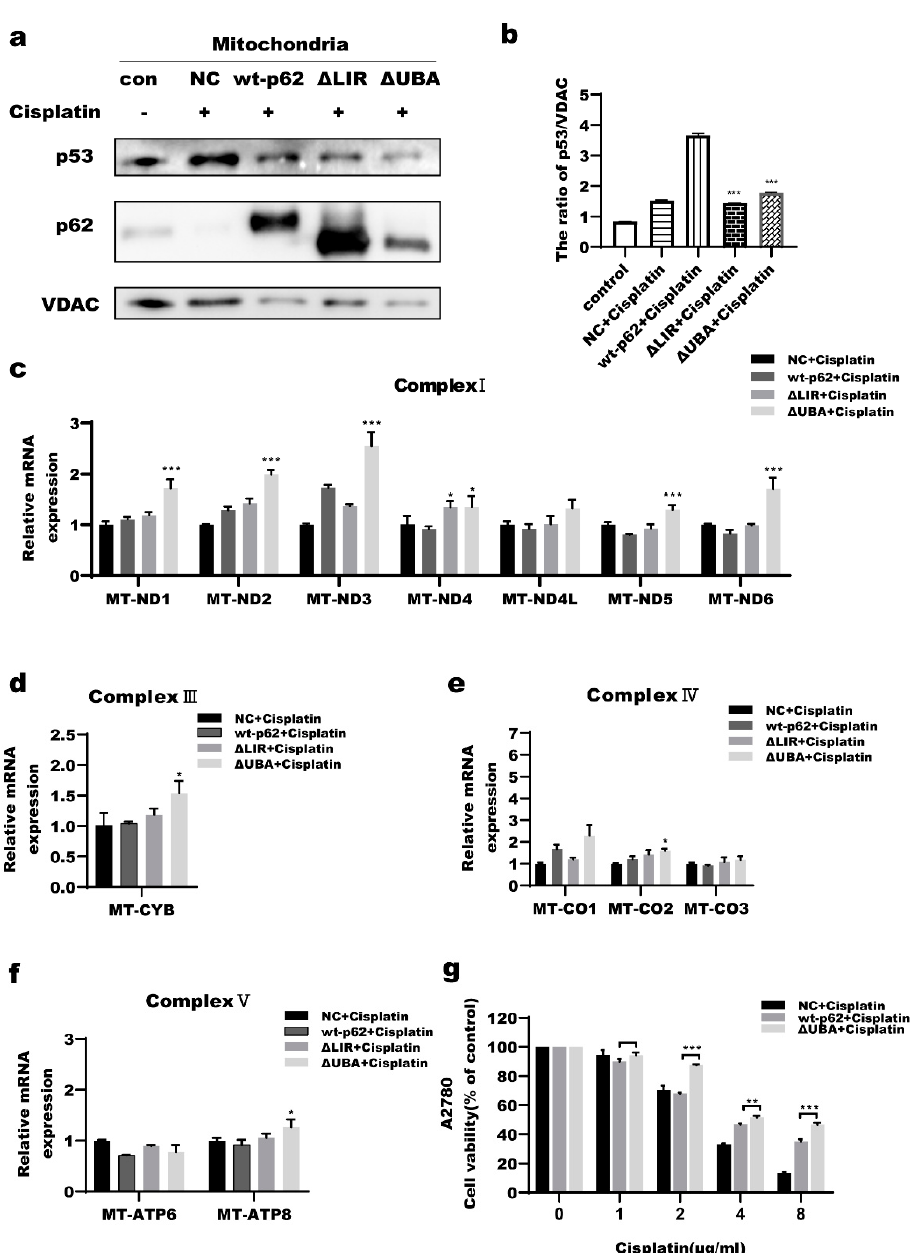
Figure 7. Deleting the ubiquitin-associated (UBA) domain of p62 inhibited mitochondrial localization of p53 in A2780 cells. ( a , b ) A2780 cells were treat with cisplatin (2 µ g/mL) for 12 h after transfection with different types of p62 for 24 h. Western blot analysis of p53 protein levels in the